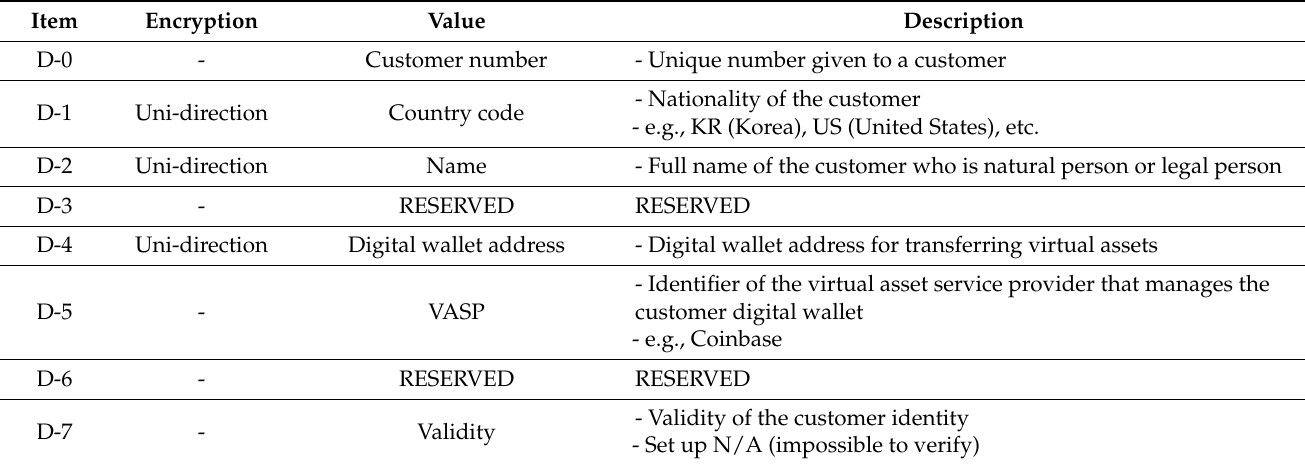
Table 8. Data format-7.